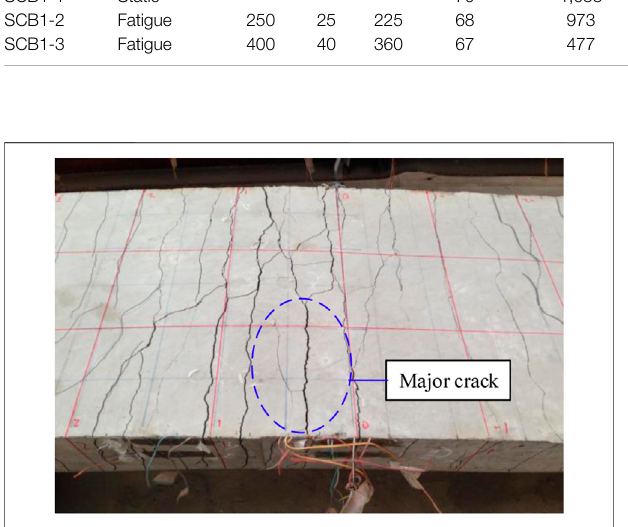
FIGURE 8 | Typical crack development